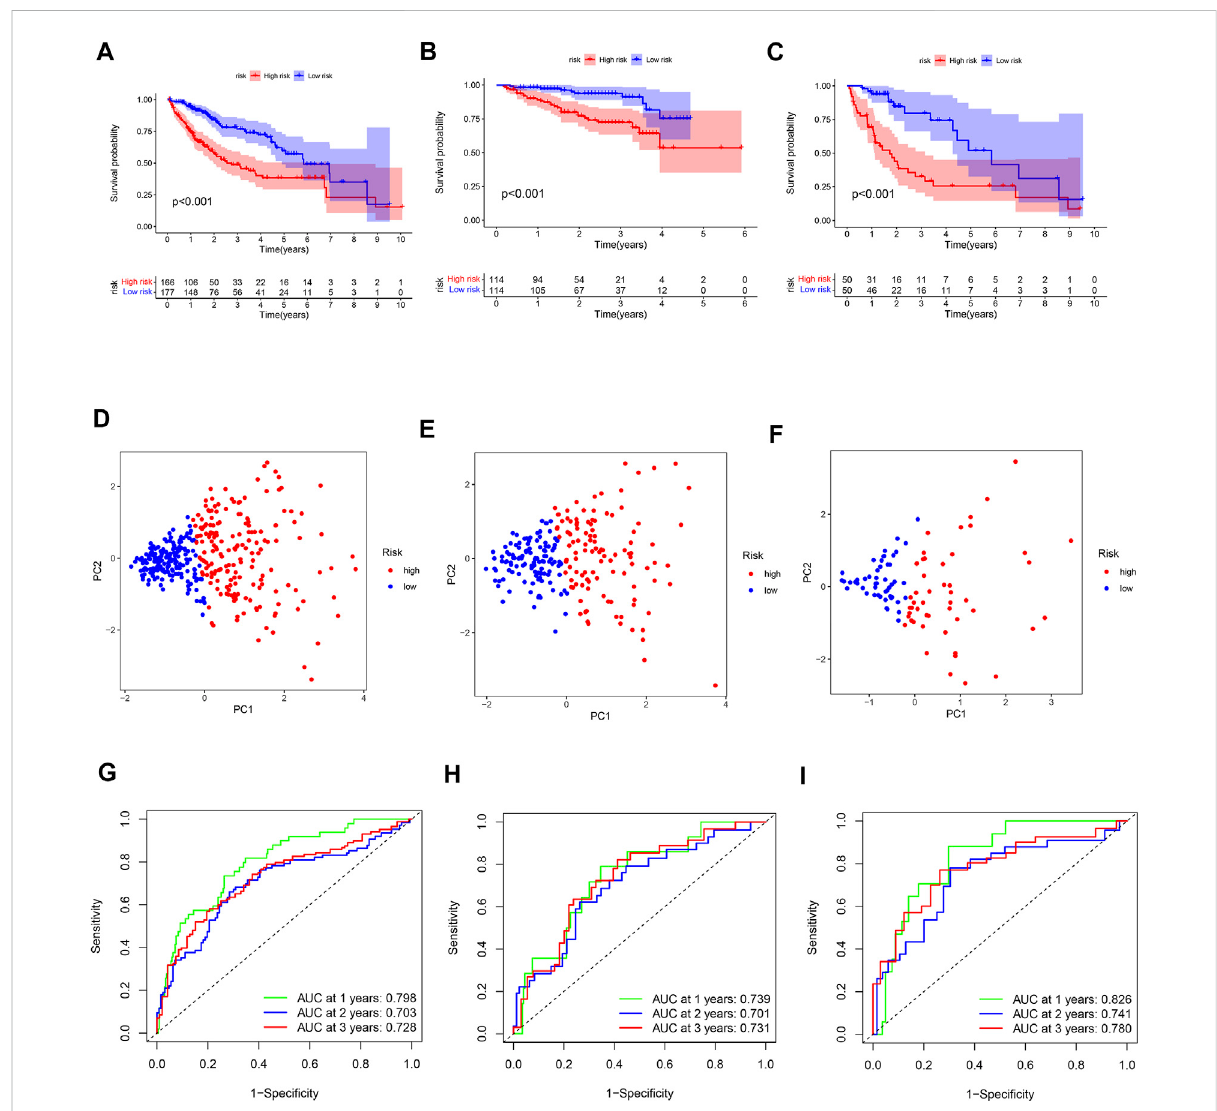
FIGURE 3 Validation of the prognostic 2-DEEG signature. (A) survival curve of TCGA cohort between high- and low-risk subgroups. (B) survival curve of ICGC cohort between high- and low-risk subgroups. (C) survival curve of local cohort between high- and low-risk subgroups. (D) PCA plot of TCGA cohort based on risk score. (E) PCA plot of ICGC cohort based on risk score. (F) PCA plot of local cohort based on risk score. (G) ROC curve of TCGA cohort. (H) ROC curve of ICGC cohort. (I) ROC curve of local